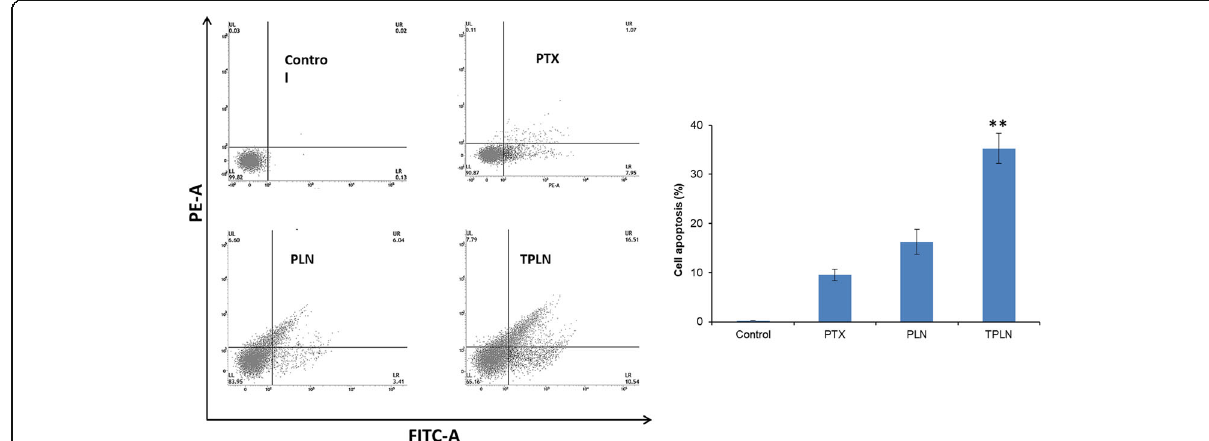
Fig. 7 Flow cytometer-based apoptosis assay. The cells were treated with respective formulation and after 24 h, cells were stained with Annexin V and PI for 15. The cells were then sorted using flow cytometer. The cells were incubated with respective formulations for 24 h. The measurement was performed n =3. * p <0.05 is the statistical difference between TPLN and PTX